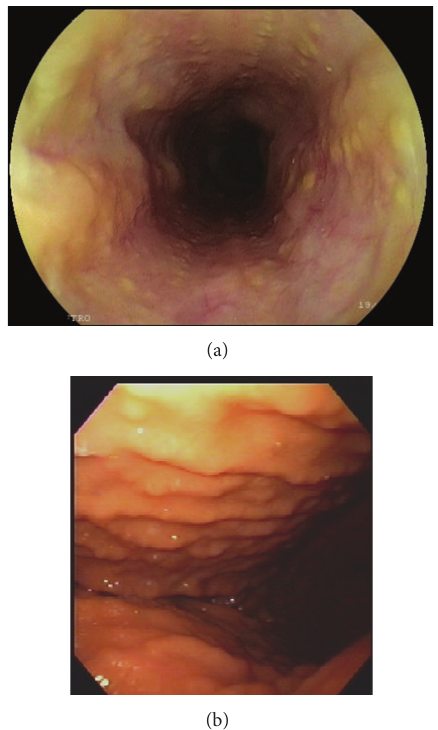
Figure 1: Upper endoscopy showing multiple yellowish nodules throughout the esophagus (a) and the body of the stomach (b).